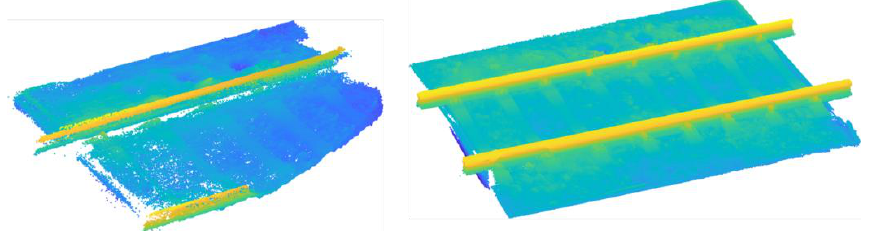
Figure 3. LiDAR data: LiVOX Avia (left) and Faro Focus 3D (right).